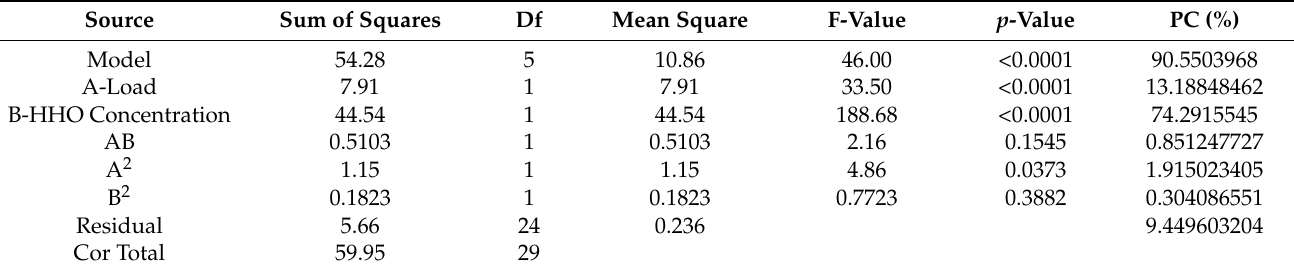
Table 11. ANOVA results for noise.